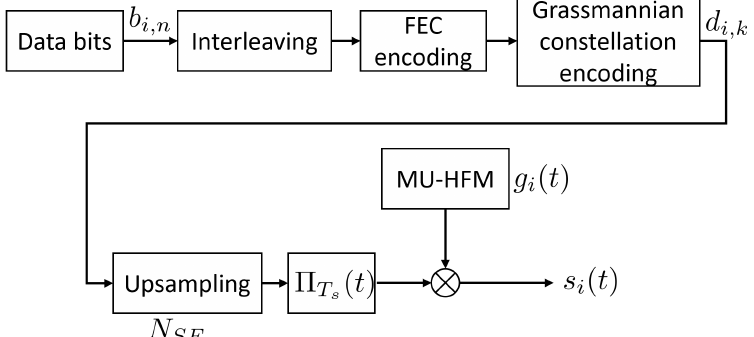
( t ) is the rectangular s